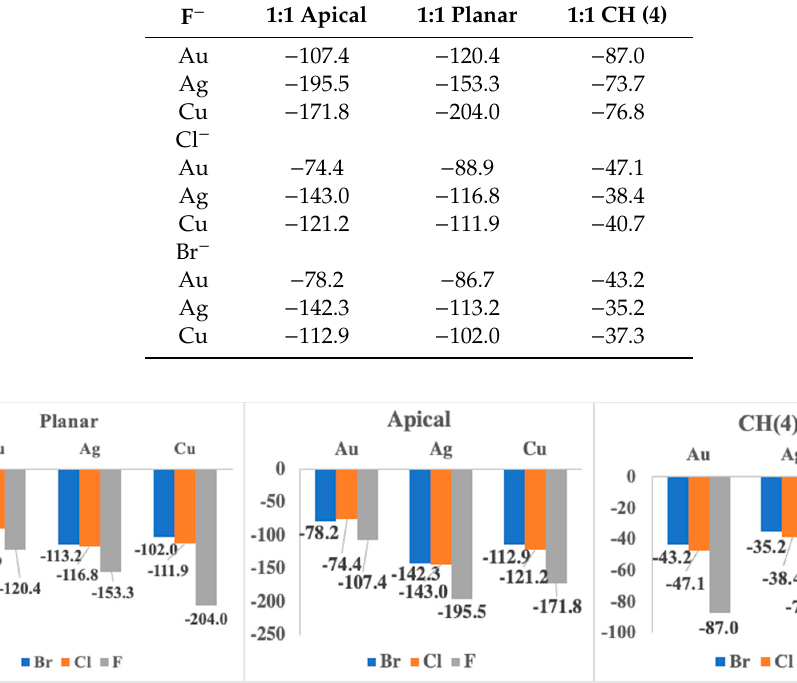
Figure 5. Binding energies in kJ/mol for each type of complex and anions with respect to the metal involved at the MP2/aug’-cc-pVDZ computational level.